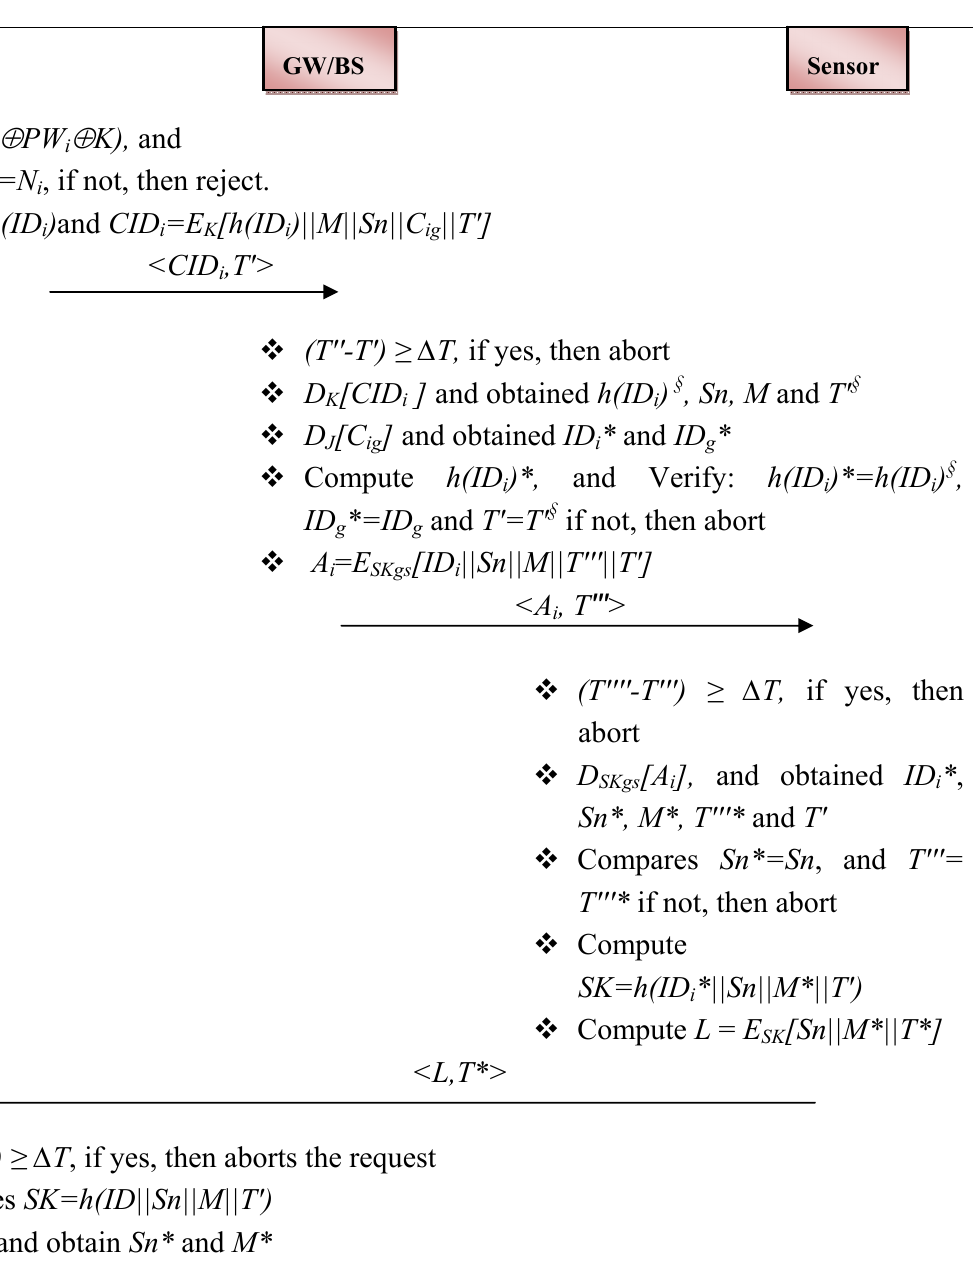
Figure 3. Flow of the Login and Authentication